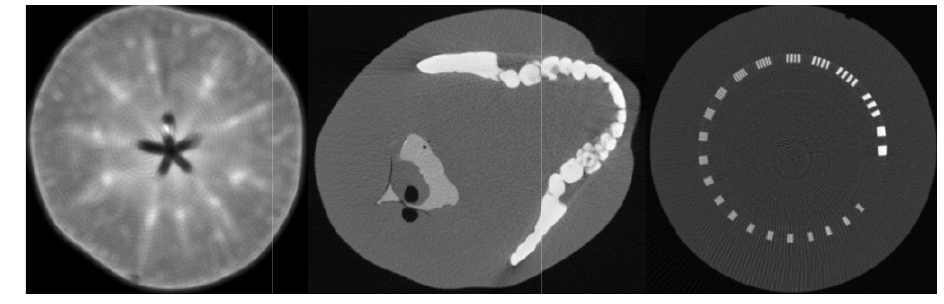
Sensors 201 Figure phanto